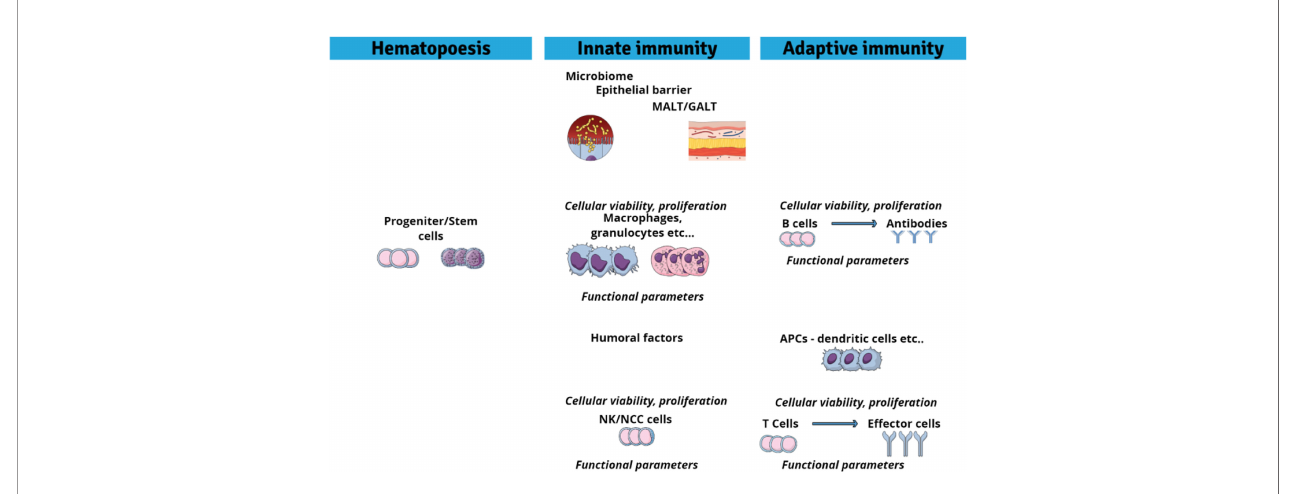
FIGURE 2 | Potential cellular targets sites for immunotoxic agents.